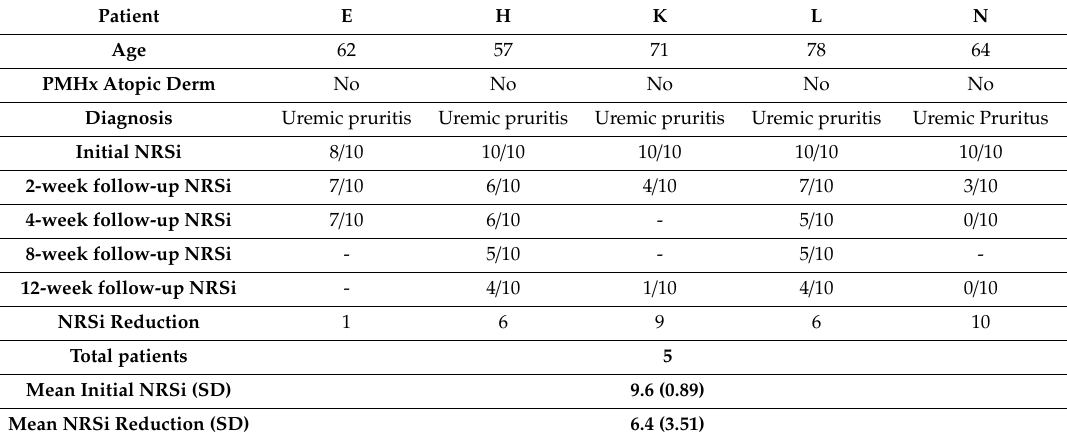
Table 3. Uremic pruritus.